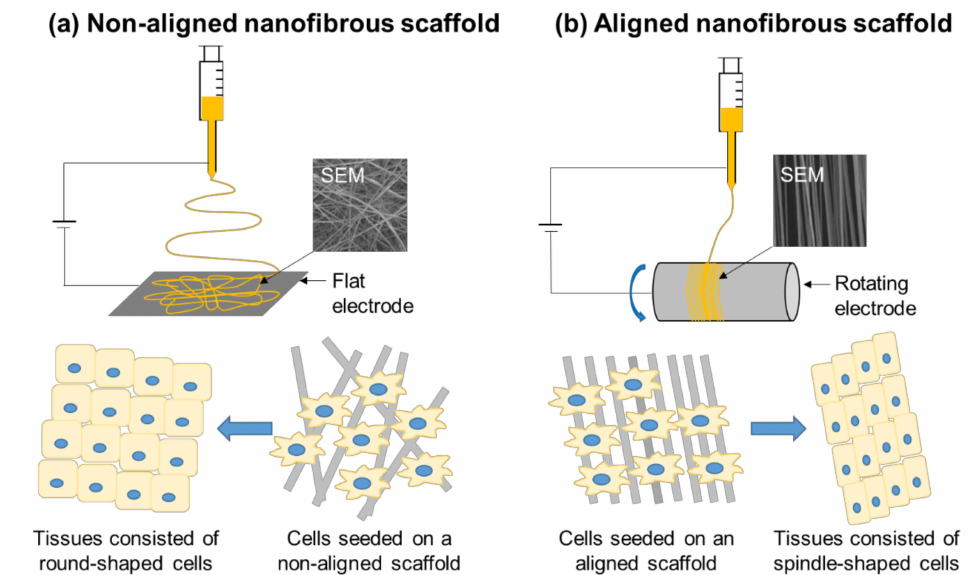
Figure 5. Schematic illustrations of tissue engineering on ( a ) an electrospun nonaligned nanofibrous scaffold and ( b ) an aligned electrospun nanofibrous scaffold. In general, cells grow with a rounded morphology on nonaligned fibers, while they grow with a spindle-shaped morphology on aligned fibers